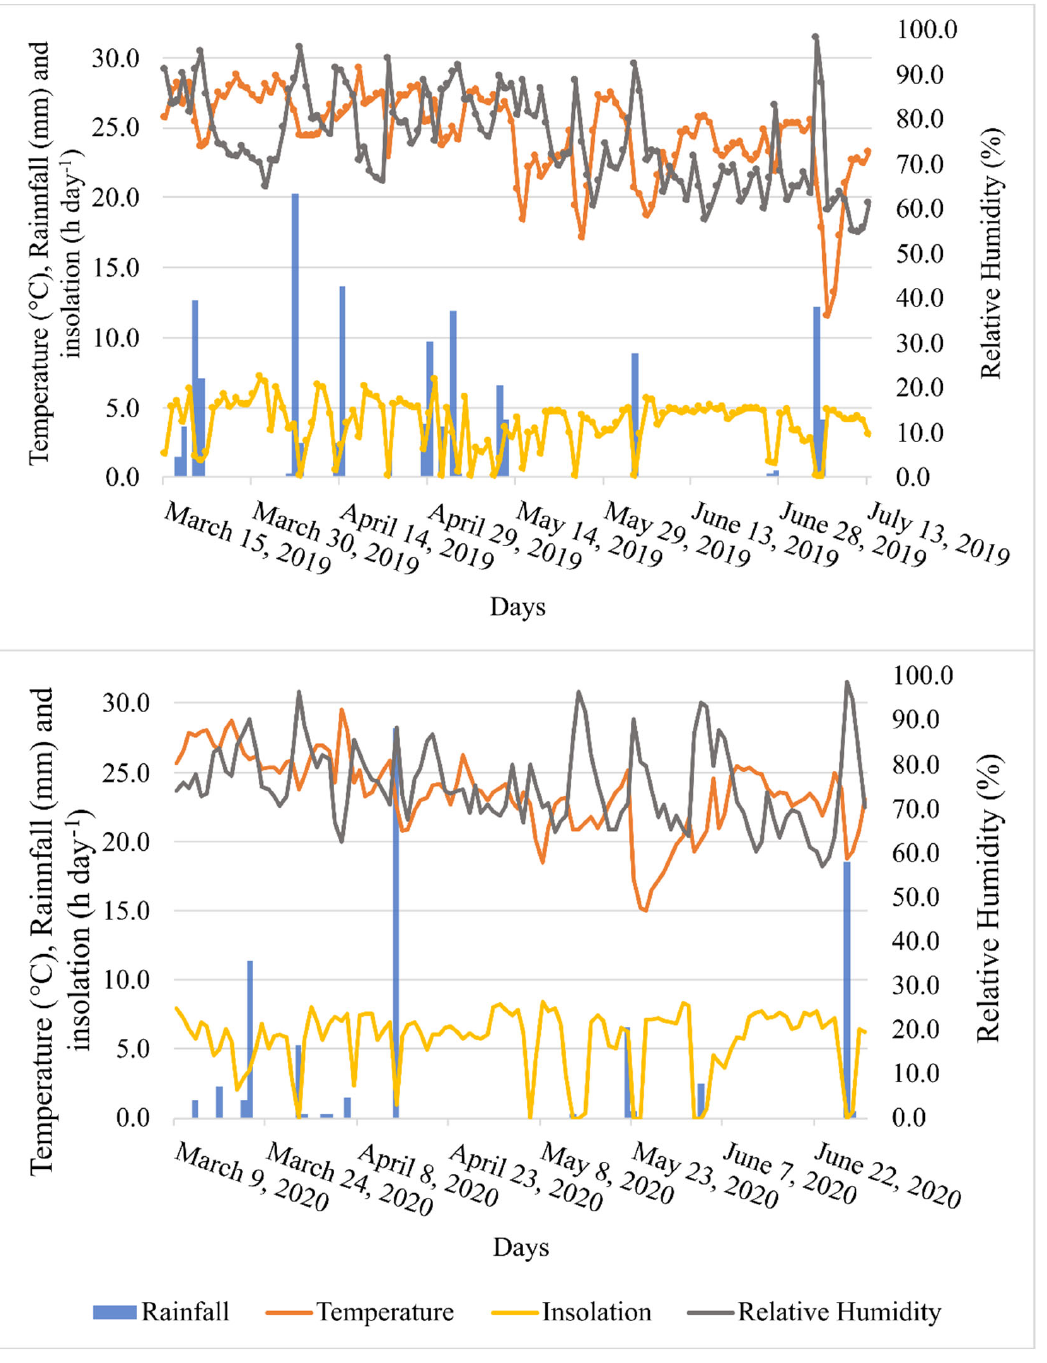
Figure 1. Climatic data: precipitation (mm), average temperature (°C), insolation (h day ‐ 1 ), and average relative humidity (%) over the experimental period. Selvíria/MS, 2019. Based on data available at clima.feis.unesp.br.